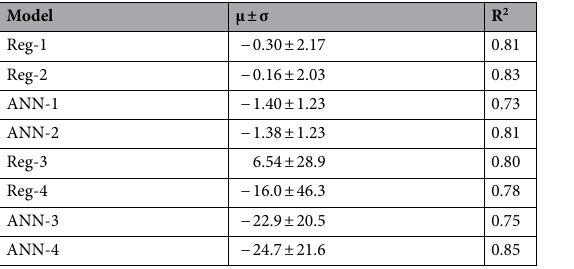
Table 6. Validation error statistics, mean error (μ), standard deviation (σ), and coefficient of determination (R 2 ) of the observed and estimated leaf area index (LAI). The validation was done by substituting the corresponding VIs from 2019 study into the models—Reg-1, Reg-2, ANN-1, ANN-2; and lateral growth (LG) using Reg-3, Reg-4, ANN-3,